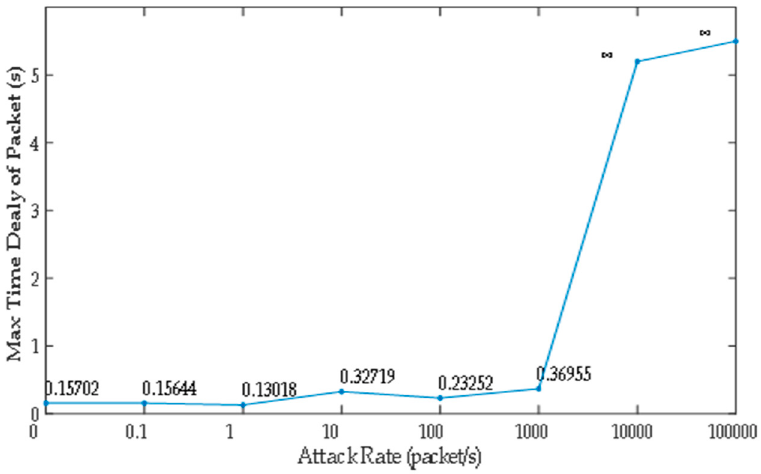
Figure 12. Max transmission time delay under different DoS attack rates.